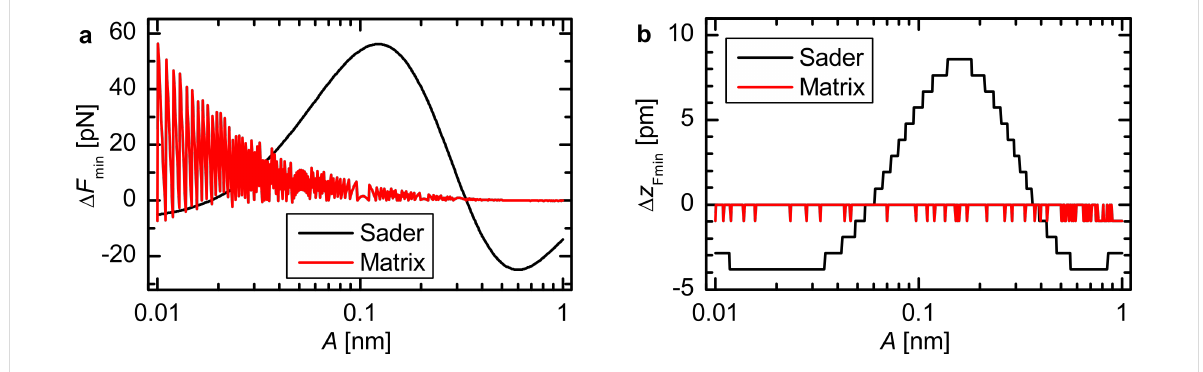
Figure 4: Amplitude dependence of the deviation in magnitude (a) and position (b) from the force minimum for the Morse force law. The steps in (b) are due to the discretization of the z -values.